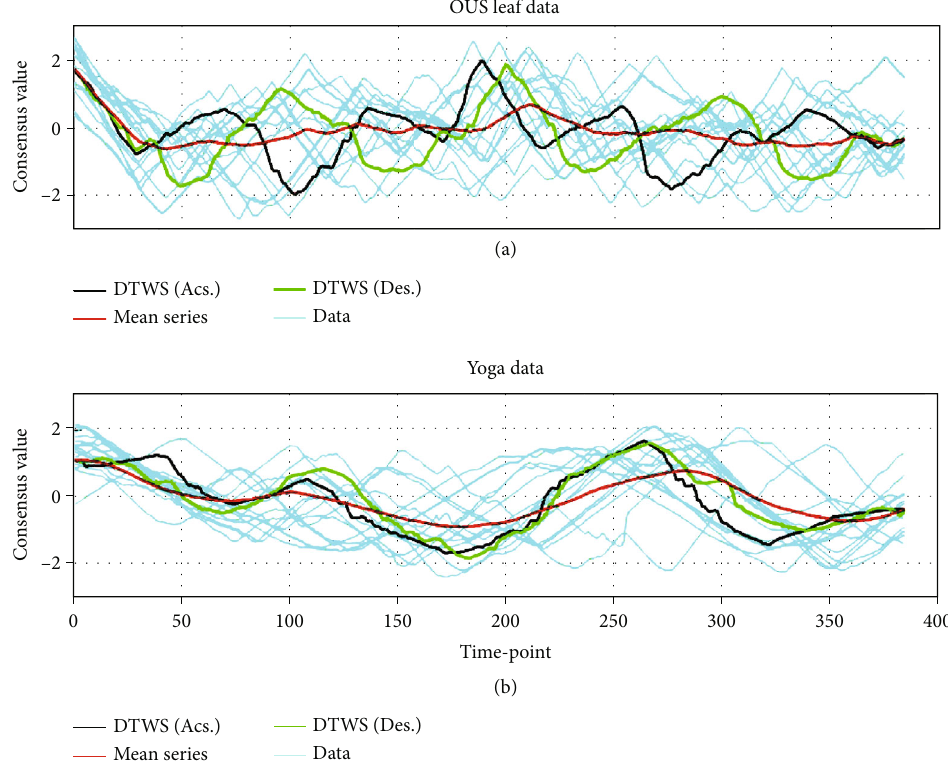
Figure 6: Mean series, DTWS with ascending hierarchy (Asc.) and DTWS with descending hierarchy (Des.) of two data sets: OSULeaf and